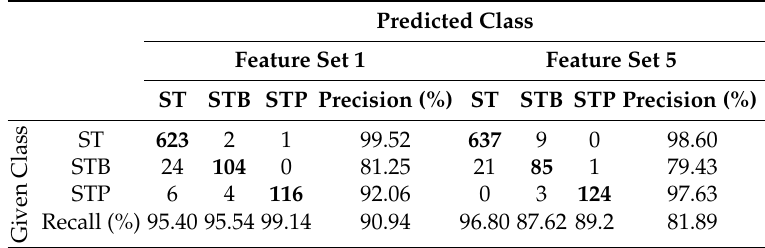
Table 13. Confusion metrics for fs1 and fs5 at the TP position achieved through